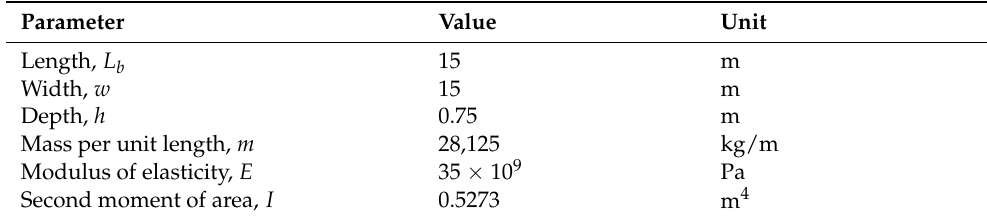
Table 1. Parameters of the bridge model.